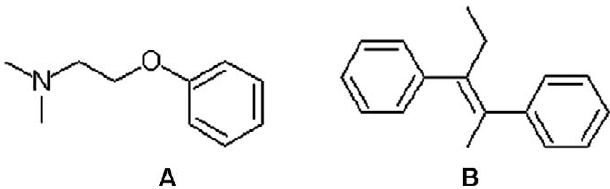
Figure 9. N-Moiety (A) and C-Moiety (B) Molecular Fragments Used in the 2D Graph Similarity Search for Decoy